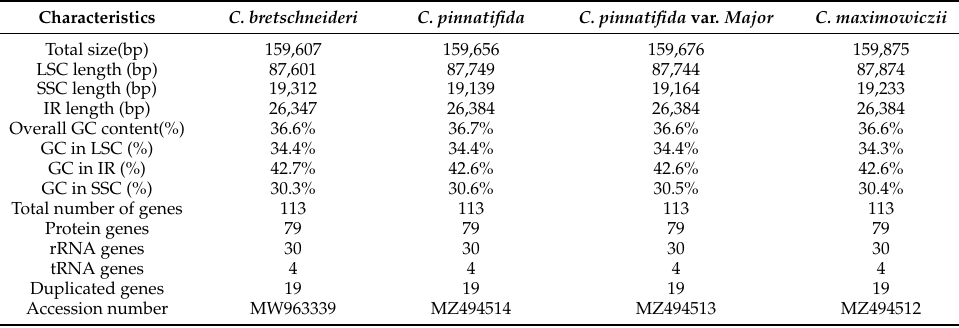
Table 3. List of annotated genes encoded by the four Crataegus chloroplast genomes. Gene Category Gene Group